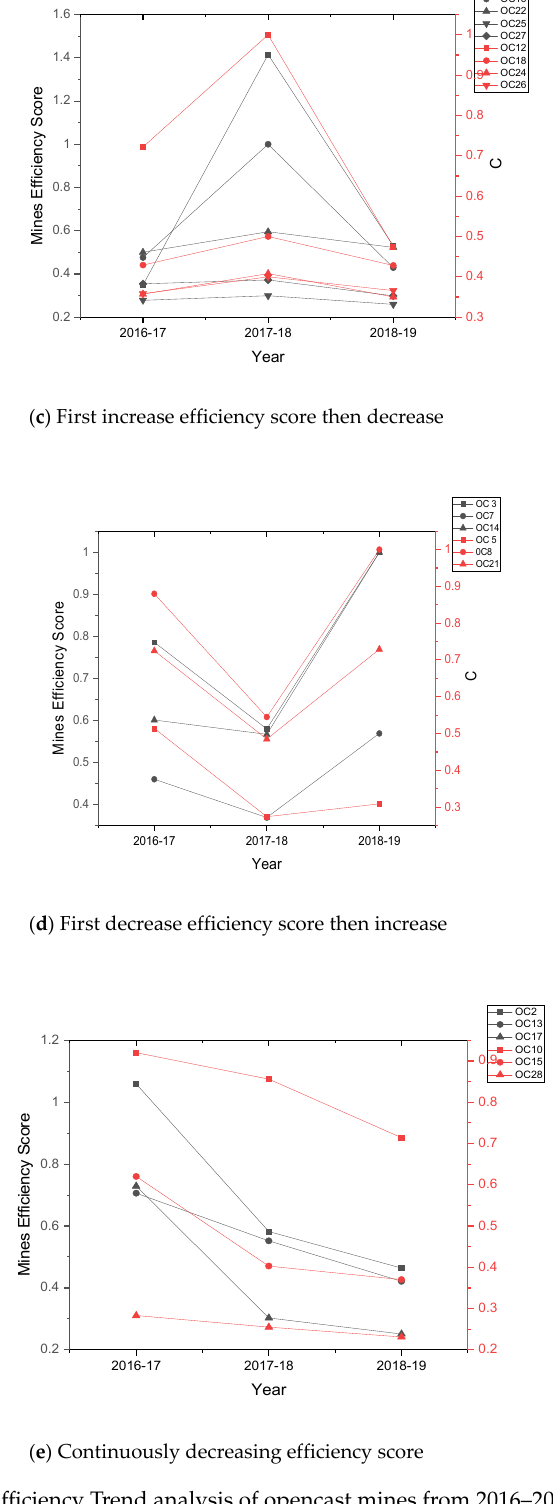
Figure 2. The E ffi ciency Trend analysis of opencast mines from 2016–2017 to Figure 2. The Efficiency Trend analysis of opencast mines from 2016–2017 to 2018–2019.